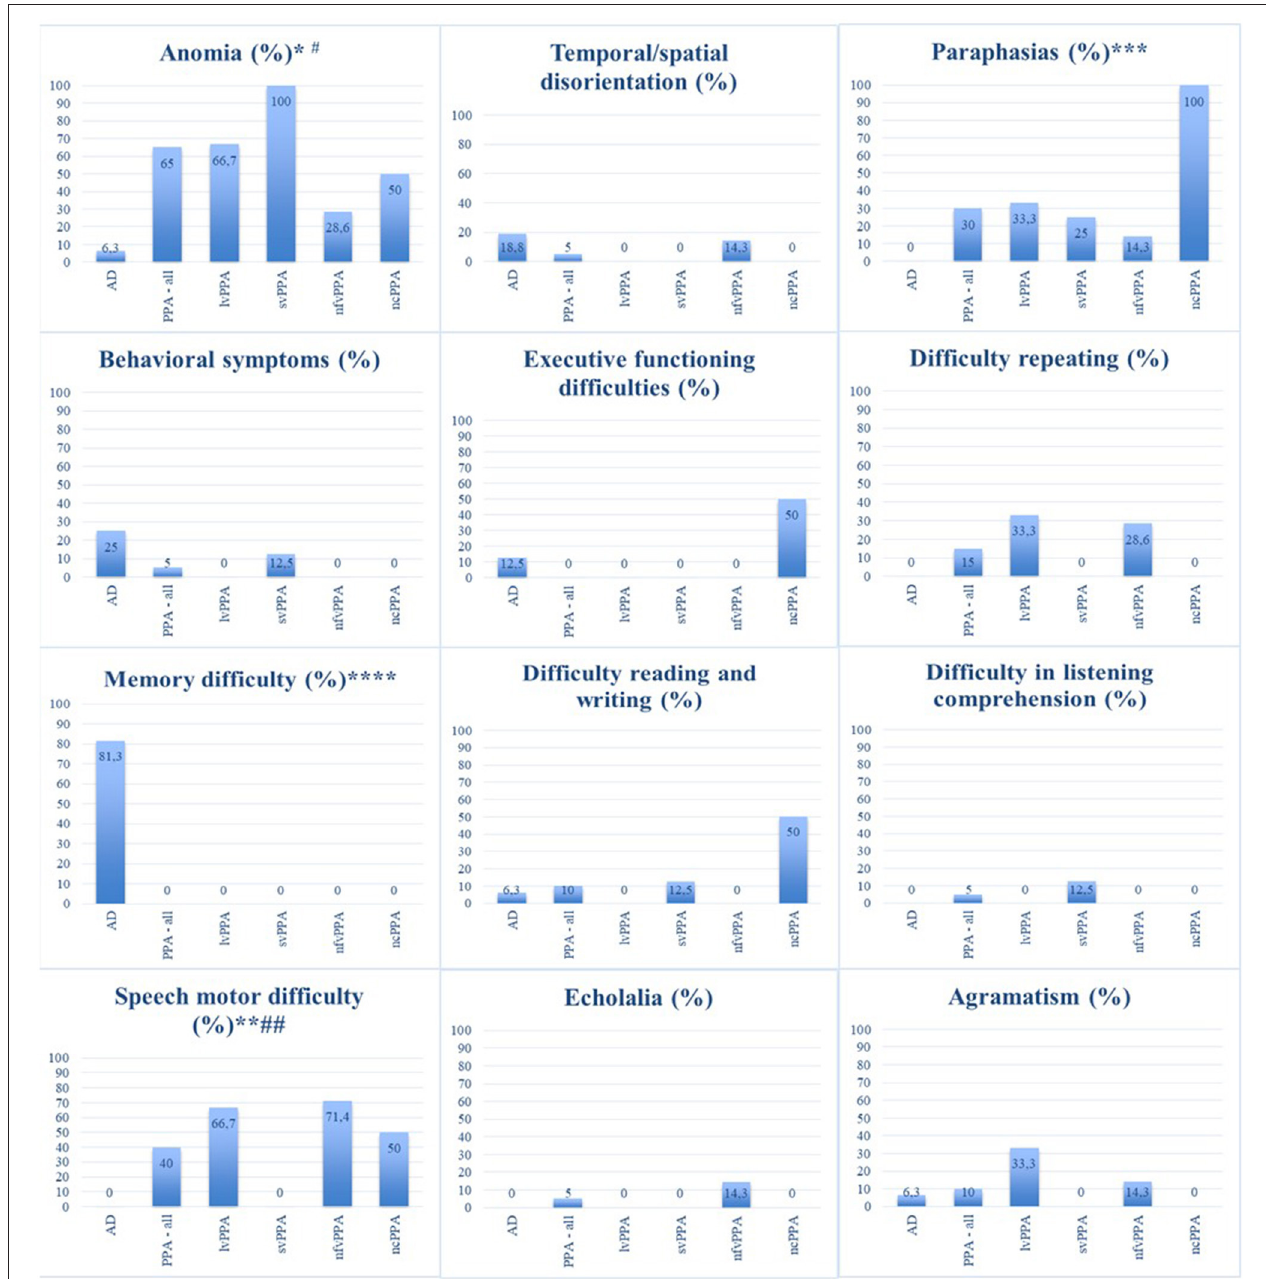
FIGURE 1 | Percentages of occurrence of the first symptoms in each group of participants. AD, Alzheimer’s disease; PPA, primary progressive aphasia; lvPPA, logopenic variant primary progressive aphasia; svPPA, semantic variant primary progressive aphasia; nfvPPA, non-fluent/agrammatic variant primary progressive aphasia; ncPPA, non-classifiable primary progressive aphasia. * Statistically significant difference for the symptom of “anomia” ( p = 0.00), when comparing PPA and AD groups. ** Statistically significant difference for the symptom of “speech motor difficulty” ( p = 0.00), when comparing PPA and AD groups. *** Statistically significant difference for the symptom of “paraphasias” ( p = 0.01), when comparing PPA and AD groups. **** Statistically significant difference for the symptom of “memory difficulty” ( p = 0.00) reported only in the AD group, when comparing PPA and AD groups. # Statistically significant difference for the symptom of “anomia” ( p = 0.04) associated with a higher frequency in svPPA, when comparing PPA groups. ## Statistically significant difference for the symptom of “speech motor difficulty” ( p = 0.03) associated with a higher frequency in nfvPPA, when comparing PPA groups.